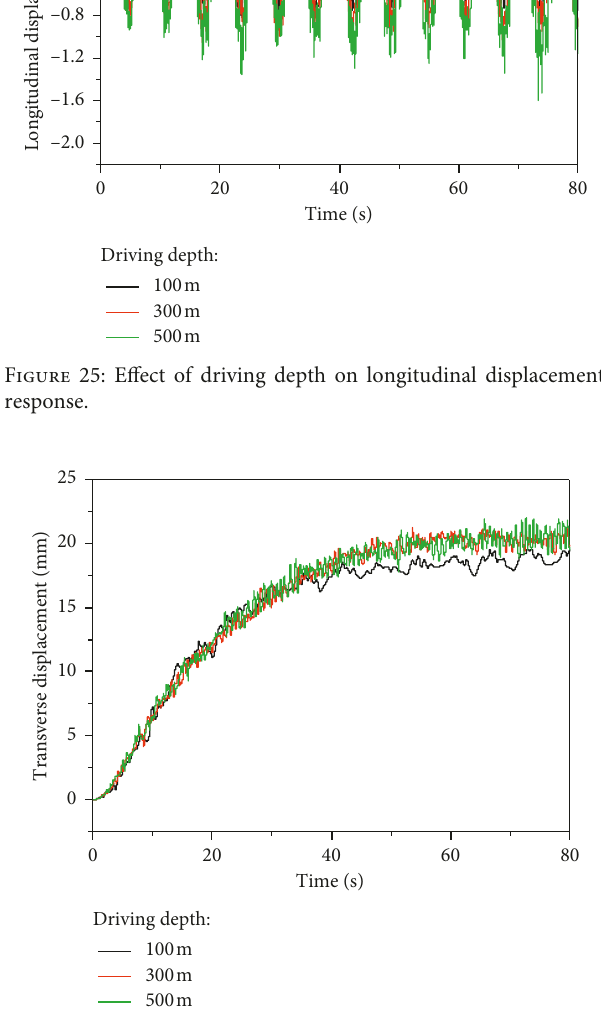
Figure 26: Effect of driving depth on transverse displacement